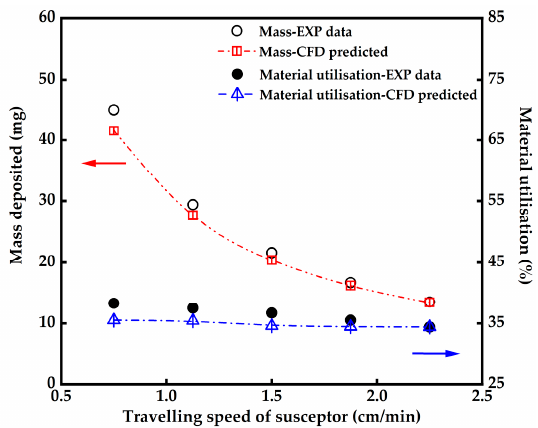
Figure 11. CdTe deposited mass and material utilisation as a function of various travelling speeds of the susceptor.